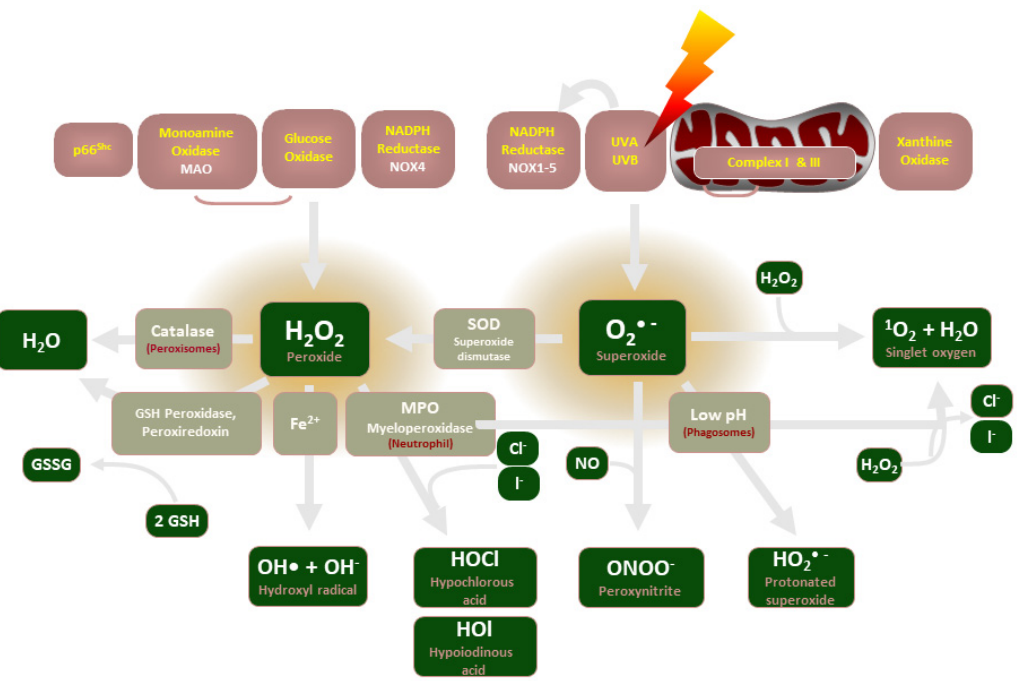
Figure 1. An illustration of the enzymes involved in ROS production and their common end-prod- ucts.